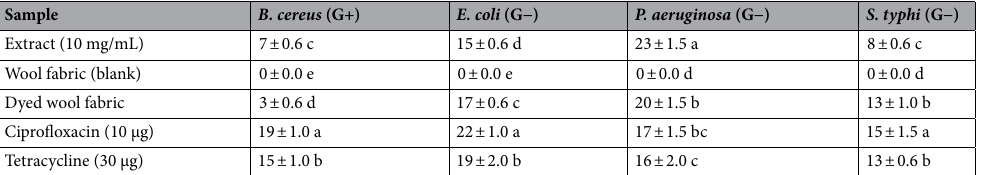
Table 4. Diameters of inhibition zones (mm) of the extract and dyed wool fabrics at 37 °C for 24 h compared with standard compounds. a–eMeans within a column followed by the same letter(s) are not significantly different according to Duncan’s multiple range test ( P =